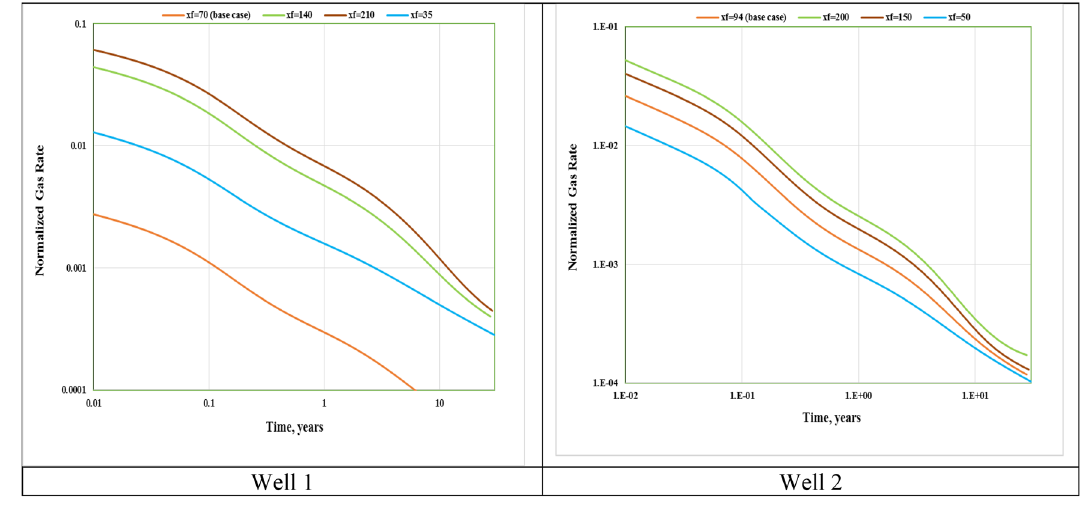
Fig. 8 Fracture half-length sensitivity